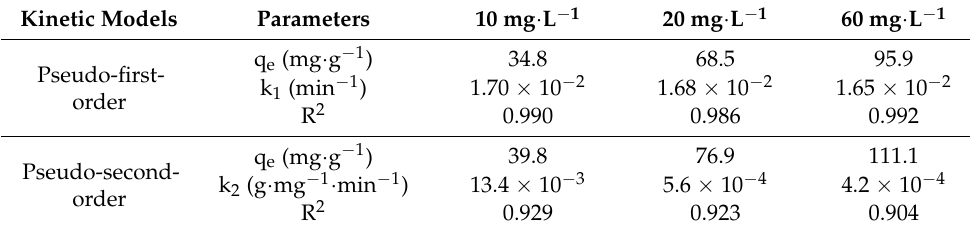
Table 1. Adsorption kinetic